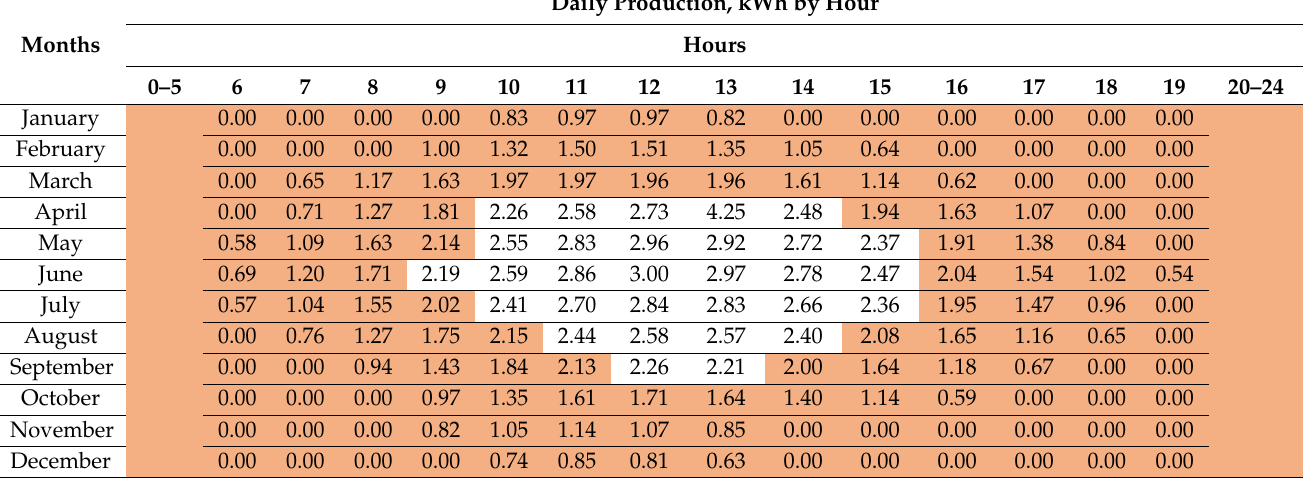
Table 19. Hours during which the power generated by the designed photovoltaic system will be sufficient to effectively operate simultaneously a refrigerator, a TV in SDR mode and a water heater (without taking into account system degradation). The hours when there is not enough electricity produced by the photovoltaic system are marked in